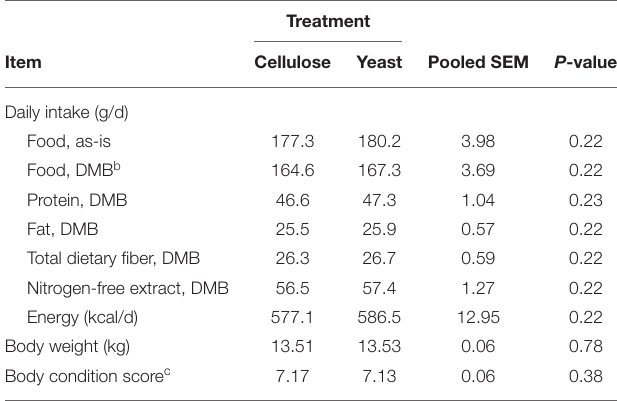
TABLE 4 | Daily food, nutrient, and energy intakes, body weight, and body condition score of yeast- or cellulose-supplemented dogs before diet transition a .